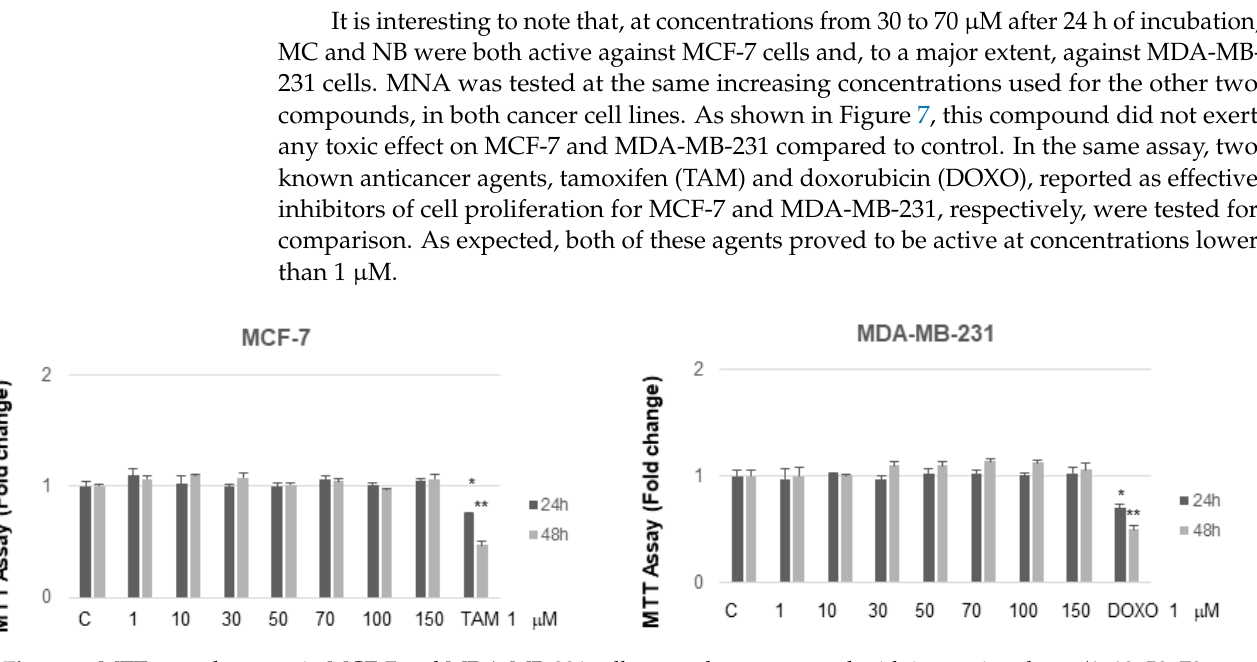
Figure 7. MTT growth assays in MCF-7 and MDA-MB-231 cells treated or not treated with increasing doses (1, 10, 50, 70, 100, 150 µM) of MNA and with 1 µM of either TAM or DOXO, respectively, for 24 and 48 h. Cell proliferation is expressed as fold change ± S.D. relative to vehicle-treated cells and is representative of three different experiments each performed in triplicate. Statistical significance was considered at * p ≤ 0.05; ** p ≤ 0.01. Statistical comparison was drawn between groups using a two-sample two-tailed t -test. C = control. Table 2. IC 50 of NB and MC for MCF-7 and MDA-MB-231 cell lines. IC 50 is defined as the drug